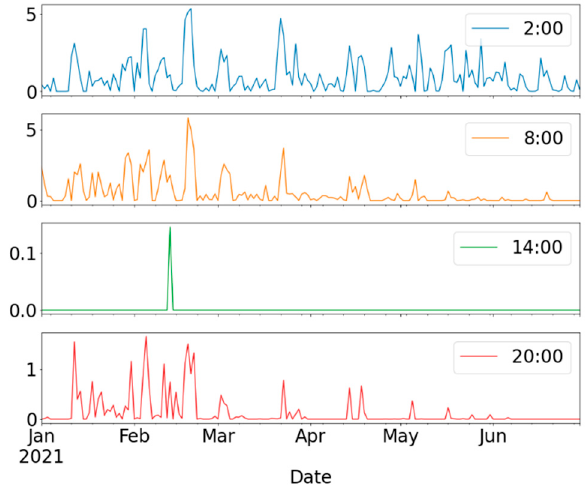
Figure 14. Six-hourly temperature inversion intensity of the Shijiazhuang site from January to June 2021 in Beijing Time.